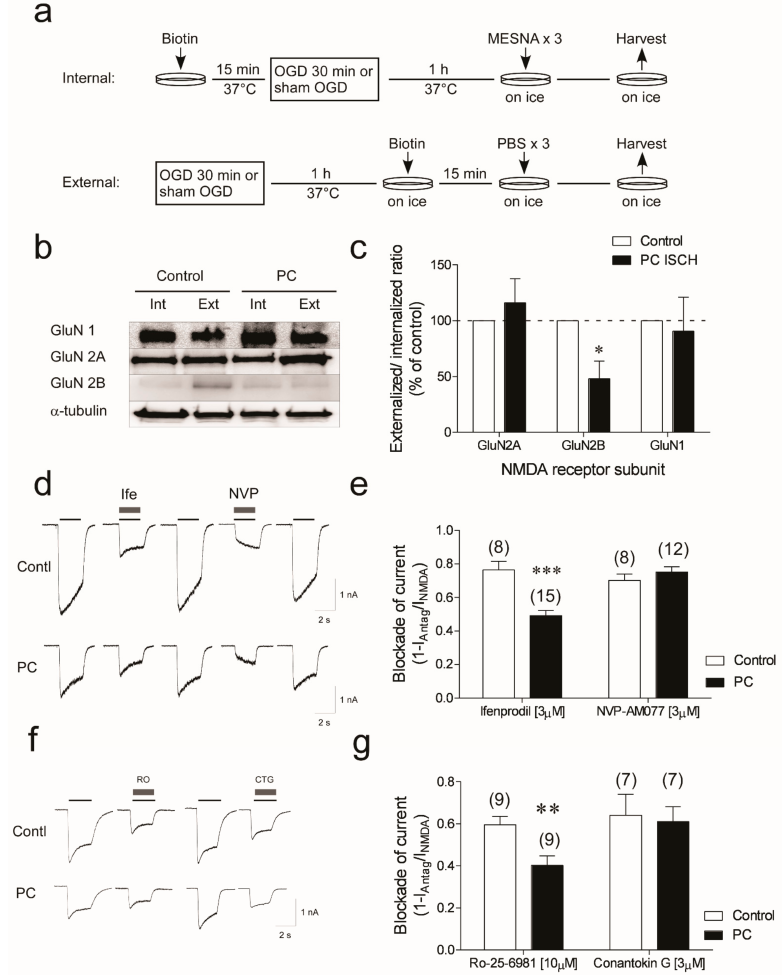
Figure 3. Change in membrane-located GluN2B, but not GluN1 and GluN2A subunits, and NMDA receptor antagonist efficacy following ischemic preconditioning. ( a ) Schematic drawing of surface protein biotinylation assay. The internal and external portions of cell lysate from control and PC neurons were then purified by streptavidin immunoprecipitation, and the level of target proteins were blotted with specific antibodies. ( b ) The externally and internally located GluN1, GluN2A, and GluN2B subunits in control and PC neurons shown in Western blots. ( c ) The quantified ex- ternal/internal ratios of the GluN1, 2A, and 2B subunits in control and PC neurons expressed as a % of control values (data are mean ± sem; * p < 0.05. Student’s 2-tail t -test performed on raw data). ( d ) NMDA current blockage with GluN2B antagonist ifenprodil and GluN2A antagonist NVP-AAM077 in control and PC neurons. Cells were held at − 60 mV, and NMDA currents were evoked with 100 µ M NMDA (black line). After currents stabilized, 3 µ M ifenprodil (grey bar) or 3 µ M NVP-AAM077 was co-applied with NMDA. Cells were recovered by washing. In some cells, both ifenprodil and NVP-AAM077 were tested. When NVP-AAM077 was given before ifenprodil, a longer period of wash time was needed, and currents could recover to 70–90% of their initial levels. In all experiments, the solutions contained 1mM TTX and 3 µ M Gly. ( e ) Inhibition profile of NVP-AAM077 and ifenprodil in control and preconditioning-ischemia-treated cells. Inhibition was determined using the formula (1-(I antag /I NMDA )). Data shown are mean ± sem ( n ) *** p < 0.001, 2-tail Student’s t -test. ( f ) Representative traces of whole-cell currents elicited by 100 µ M NMDA with 3 µ M of conantokin-G, which are compared with those that received 3 µ M of RO25-6981 co-application in control and PC neurons. ( g ) The percent of inhibition of current (1-(I Antag /I NMDA )) calculated from I ss in control and PC neurons in the presence of 3 µ M conantokin-G and R0-25-6981. Data are mean ± sem ( n ) ** p < 0.01, 2-tail Student’s t